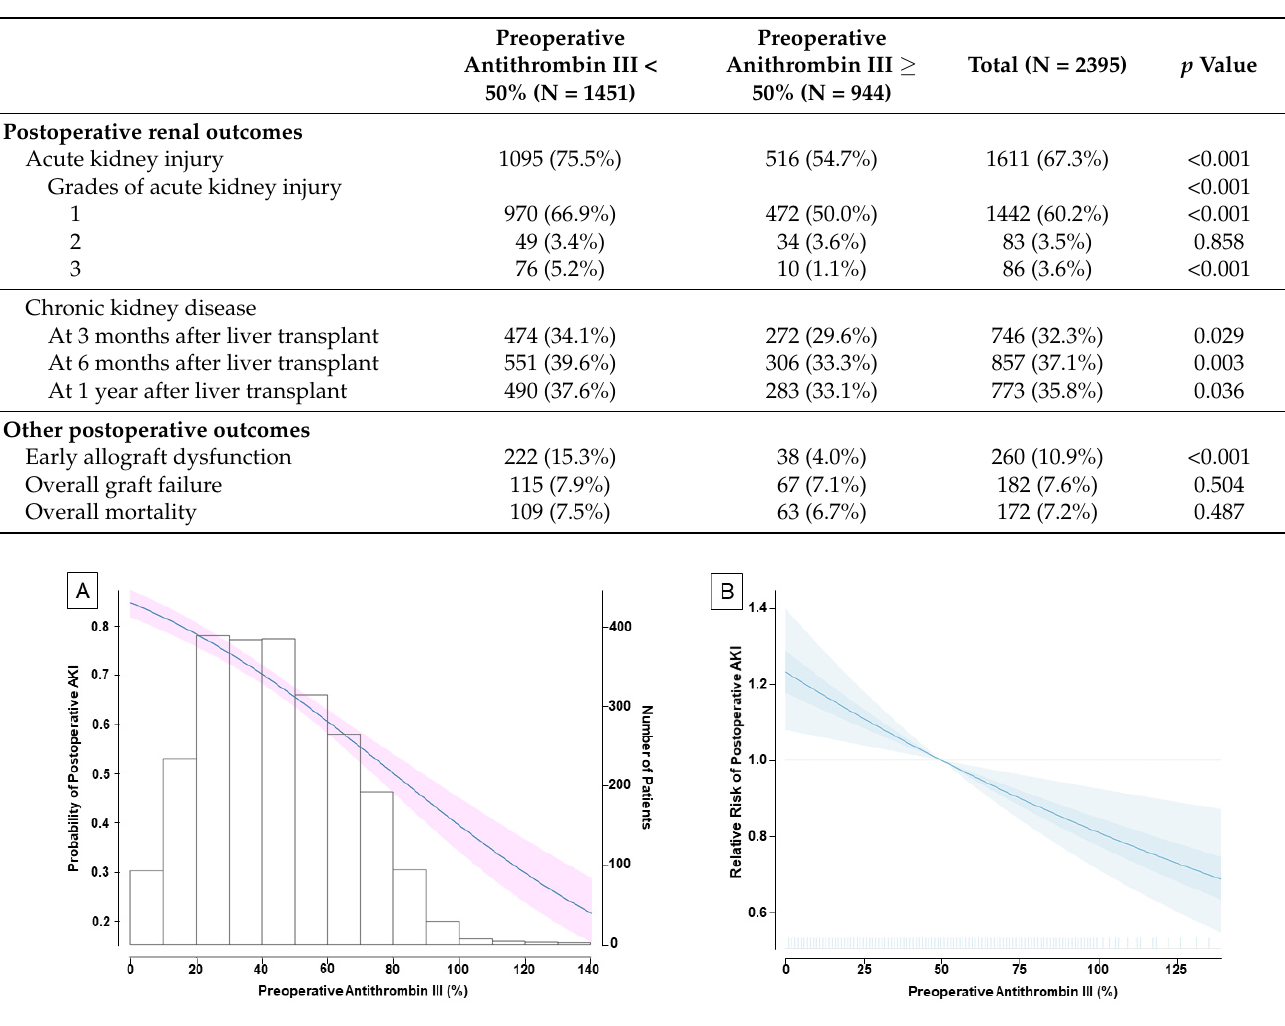
Figure 2. The association between preoperative antithrombin III (ATIII) and postoperative acute kidney injury. The solid line indicates the probability on a continuous scale value, and the shaded areas indicate 95% confidence interval ( A ). The multivariate-adjusted relative risk plot showing the relationship between preoperative ATIII and postoperative acute kidney injury ( B ). Estimates are adjusted for independent confounders from multivariable generalized logistic regression model. The solid lines and translucent band depict relative risk and 95% confidence intervals of those estimates.